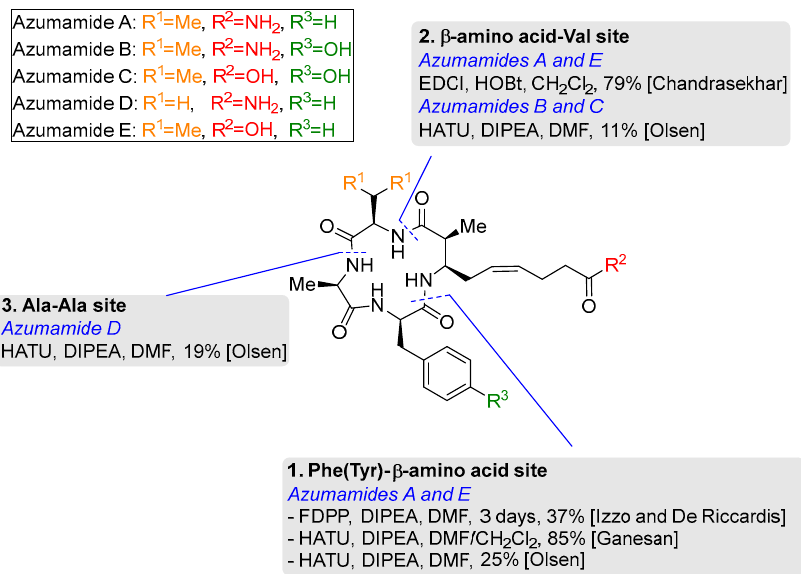
Figure 2. Macrocyclization of azumamides A-E.